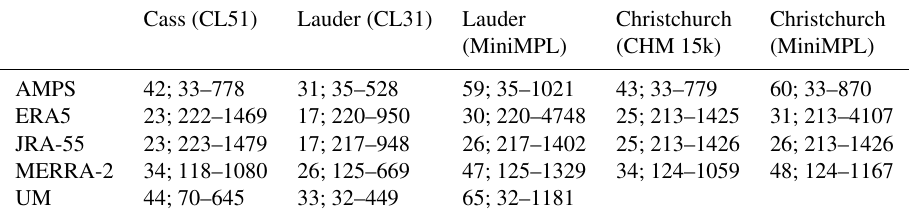
Table 7. Number of models levels and vertical resolution in the range of the instrument at the locations of the case studies. The first number is the number of levels, followed by the minimum and maximum distance range between adjacent model levels in the lidar’s range